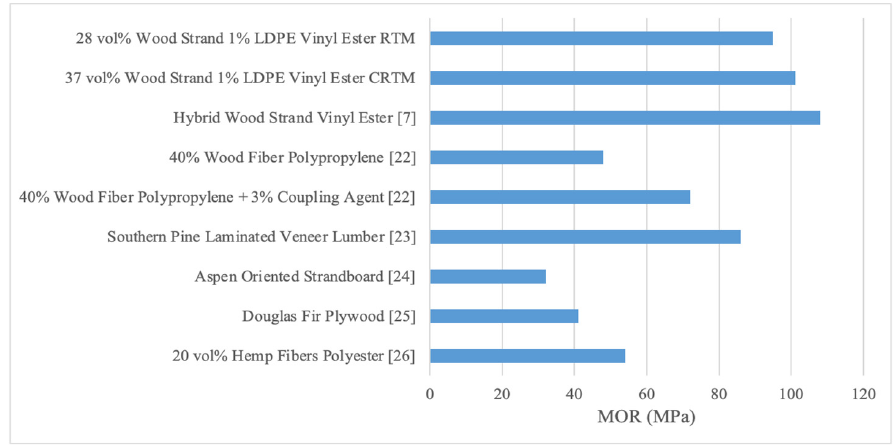
Figure 12. Bending strength properties of RTM and CRTM wood strand panels compared to other panels from published data ([7,22–26]).